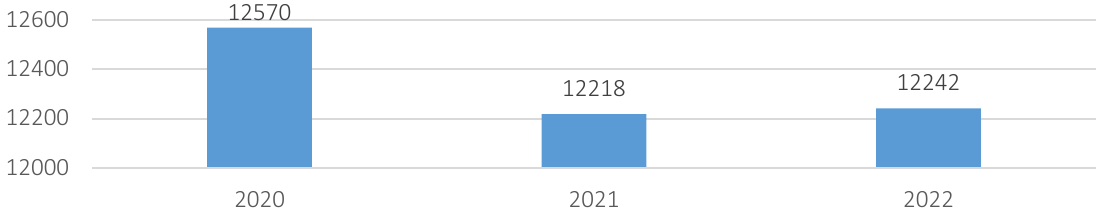
Figure A2. The number of students of Sumy State University at all levels of education